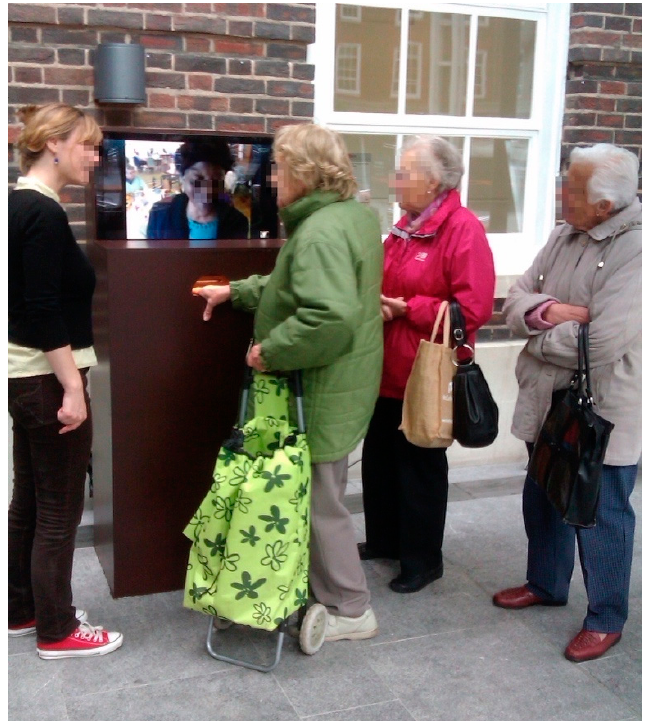
Figure 6. Three women (to the right of the TT) from a local community club using the TT. The three older women from the community club came to try out the TT because they had read about the ‘Talking TV’ in the charity’s newsletter. Permission granted by Dr Magnus Moar.